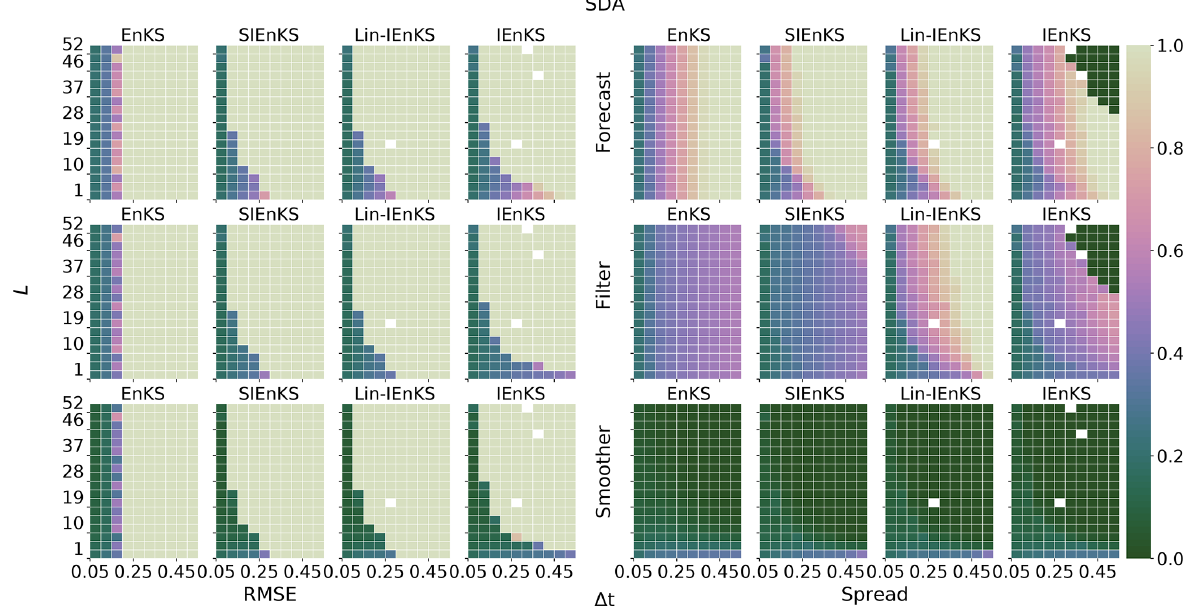
Figure 21. Lag length L on the vertical axis and (cid:49)t on the horizontal axis. SDA, tuned inflation, and ensemble size N e = 21 are indicated.